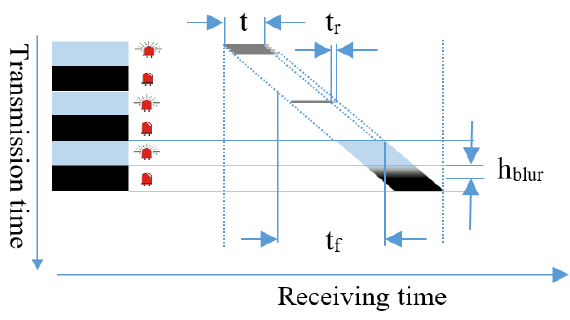
Figure 11. Effect of shutter speed in the received image. ( a ) 1000 Hz of shutter speed. ( b ) 2000 Hz of